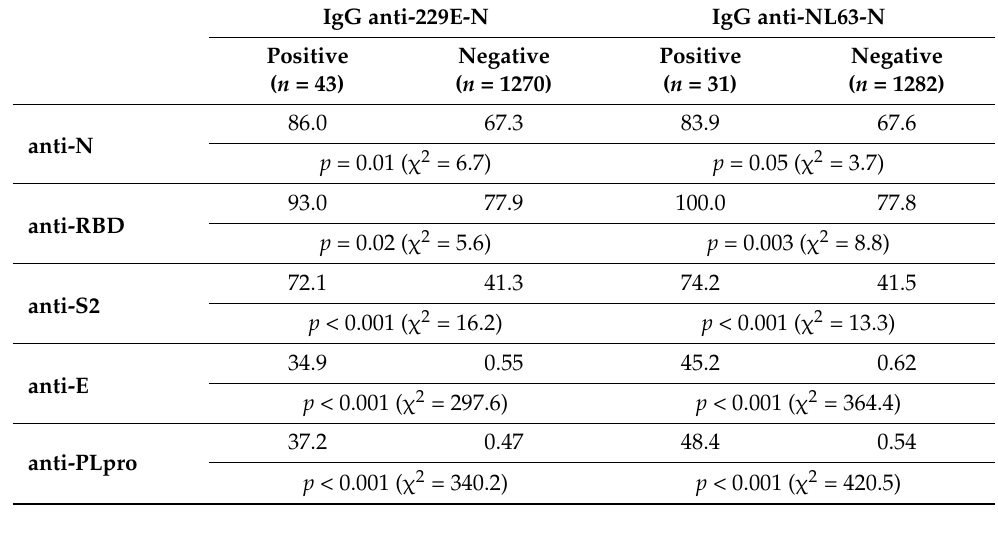
Table 2. Prevalence of anti-SARS IgG antibodies in patients testing seropositive and seronegative for IgG antibodies against 229E and NL63 nucleocapsid (N).